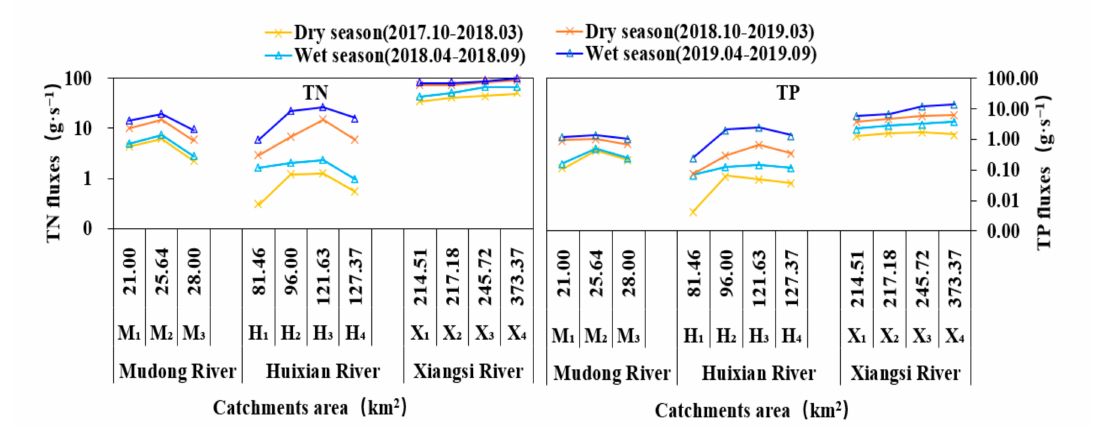
Figure 7. The average TN and TP fluxes at the eleven catchment scales in the dry and wet seasons.